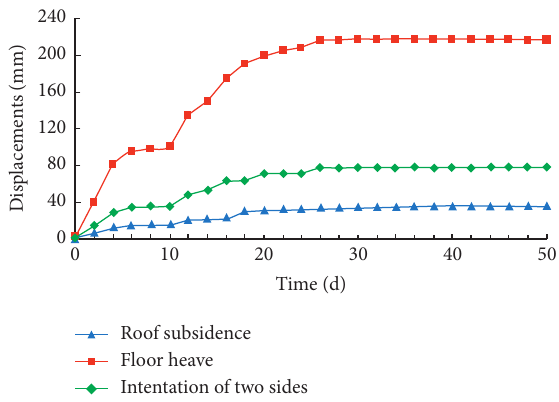
Figure 14: Displacement time curve of roadway surrounding